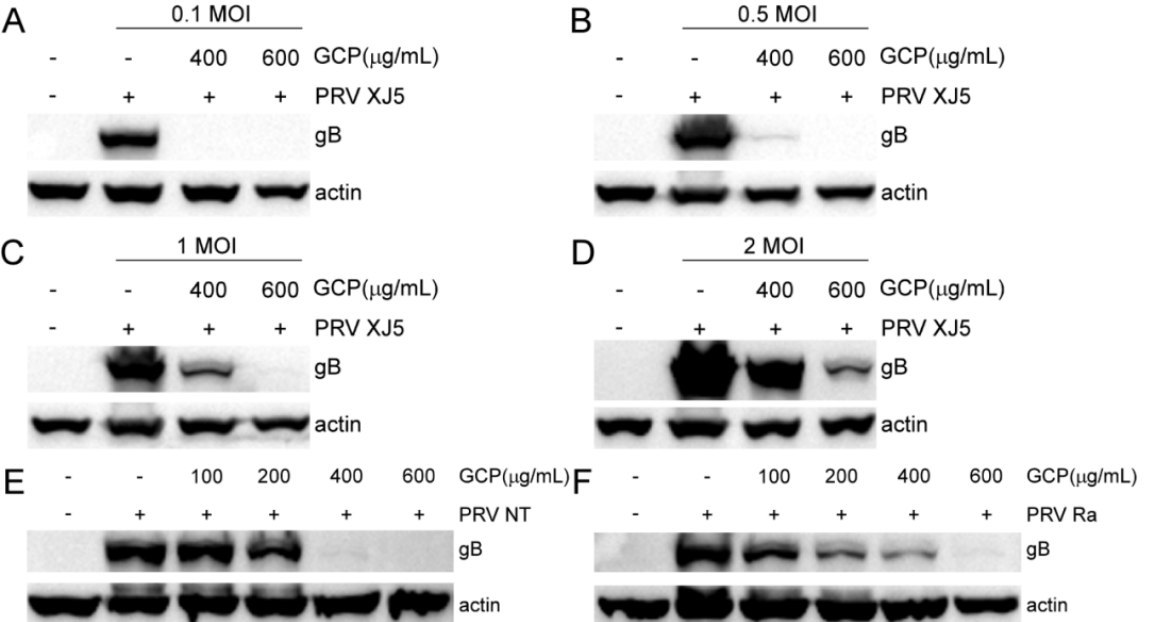
Figure 3. GCP reduced different MOI and PRV strains of infection. ( A – D ) GCP—preincubated PK-15 cells were incubated with PRV XJ5 at an MOI of 0.1, 0.5, 1, or 2. The expression levels of gB protein and actin were analyzed by Western blot. ( E , F ) GCP—preincubated PK-15 cells were incubated with PRV NT (MOI = 0.1) or PRV Ra (MOI = 0.1). The expression levels of gB protein and actin were analyzed by Western blot.